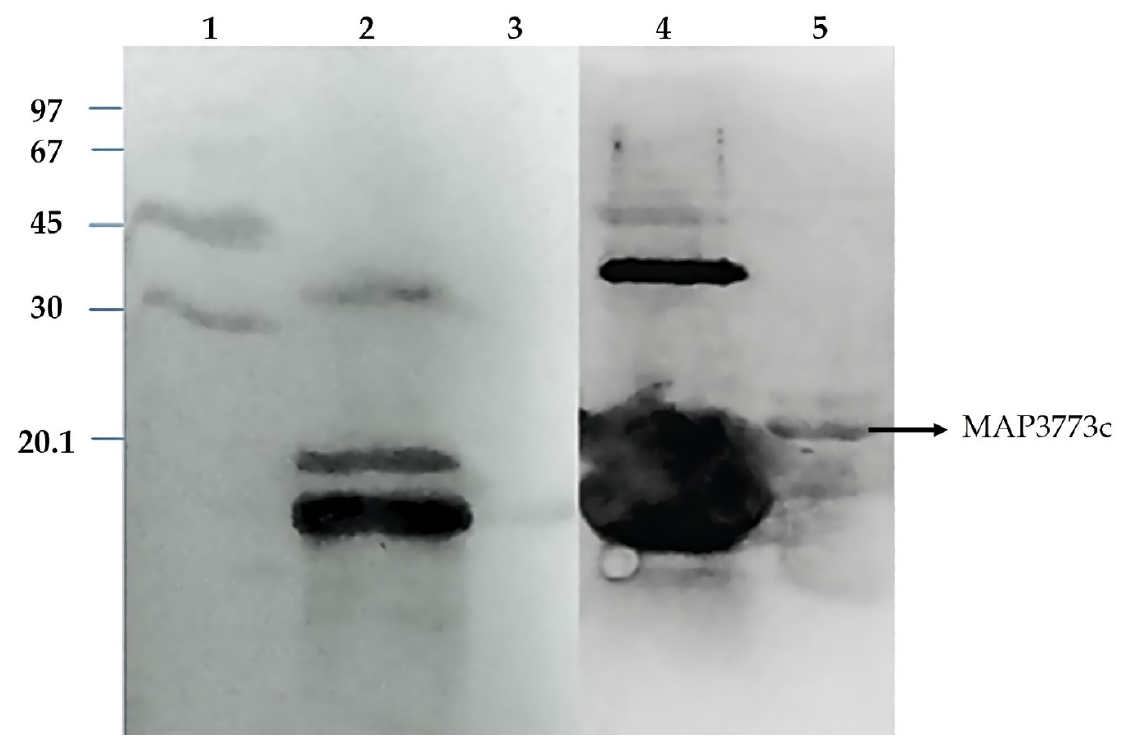
Figure 8. Western blot analysis of MAP3773c tested with antibodies raised against recombinant FurA and FurB from Anabaena sp. PCC7120. Line 1, MWM; Line 2, Western blot of FurA from Anabaena sp. PCC7120 protein tested with antibodies raised against FurA; Line 3, MAP3773c tested with antibodies anti-FurA from Anabaena sp. PCC7120; Line 4, FurB from Anabaena sp. PCC7120 tested with anti-FurB antibodies; Line 5, MAP3773c tested with Anabaena sp. PCC7120 anti FurB antibodies.